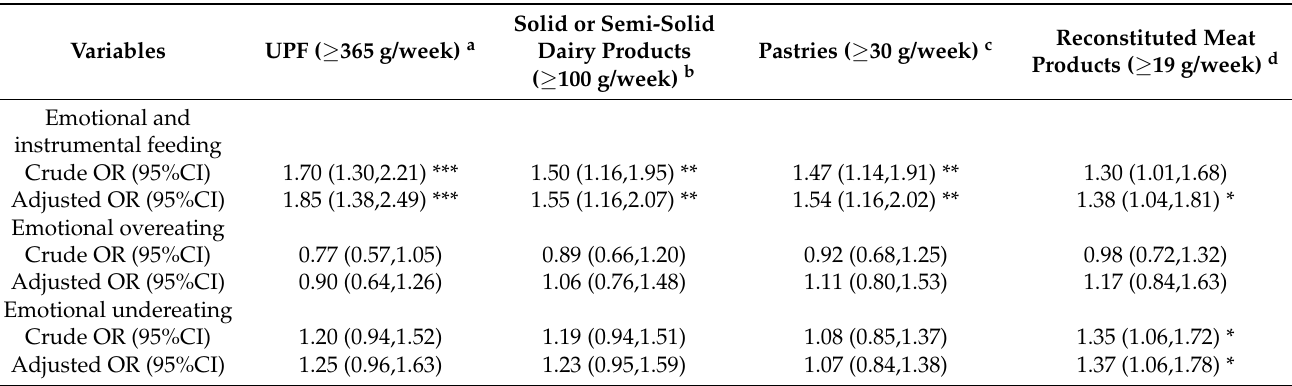
Table 5. The associations between children’s amount of UPF consumption and caregivers’ emotional and instrumental feeding, as well as children’s emotional eating ( n = 408).